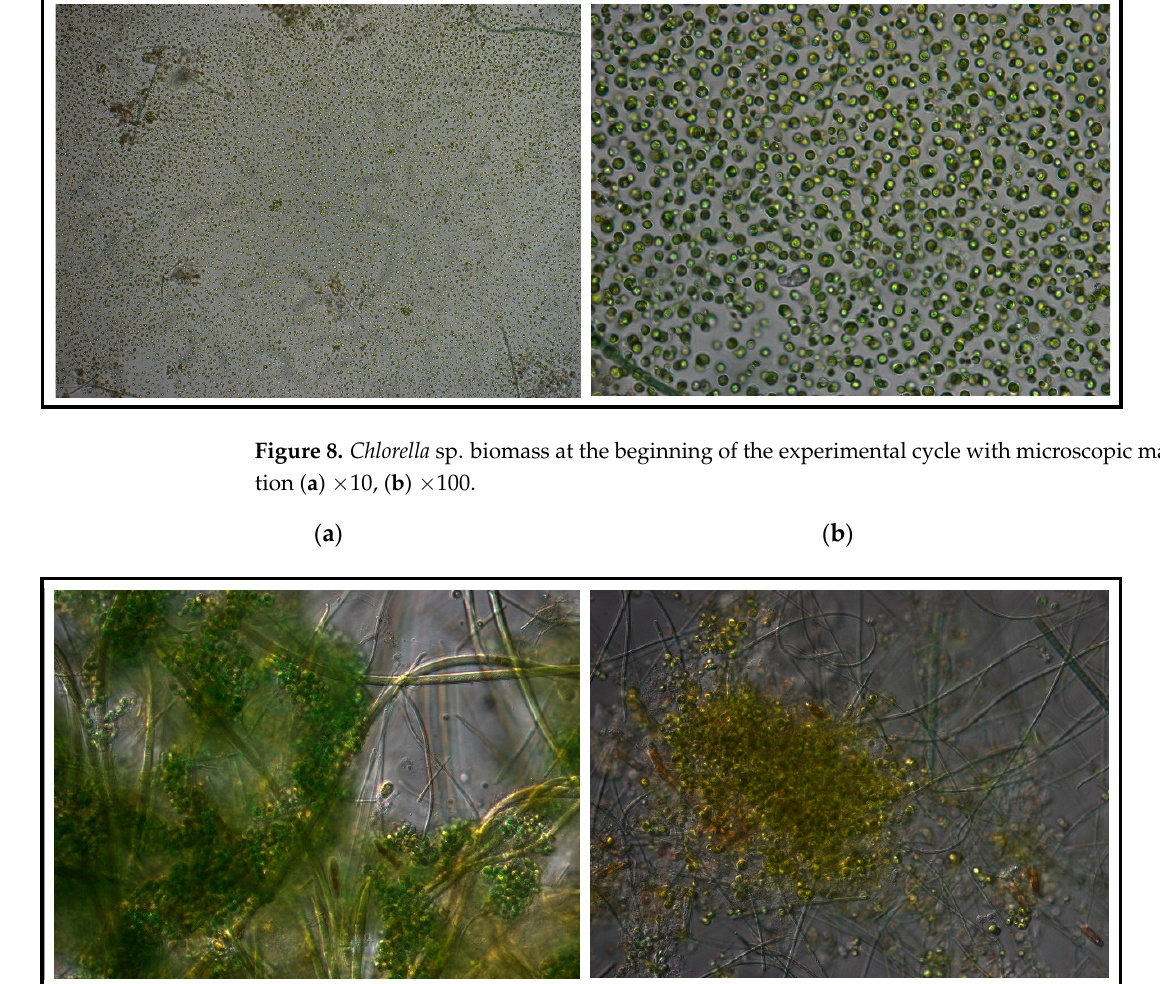
Figure 10. Characteristic views with microscopic magnification ×100 of the evolving M-BGS after 45 days of H-PBR.